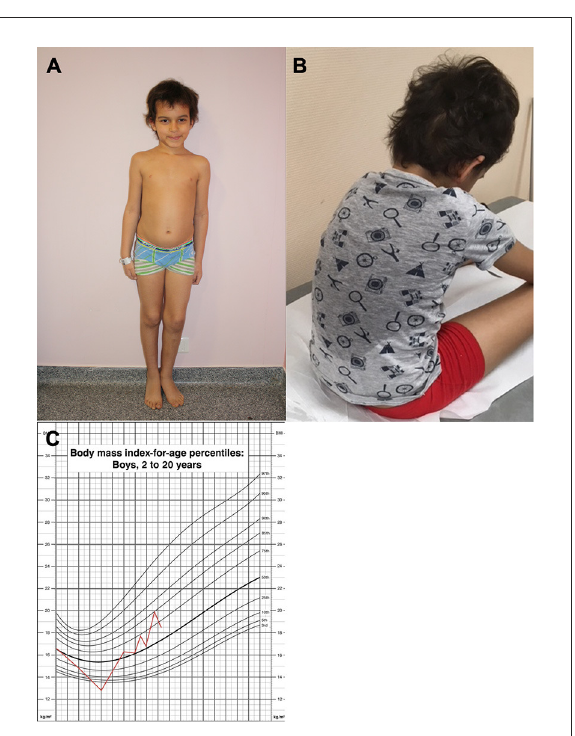
FIGURE2 Pictures of a patient of the cohort. Panel showing (A) normal BMI at diagnosis (B) excessive sweating (C) follow-up of